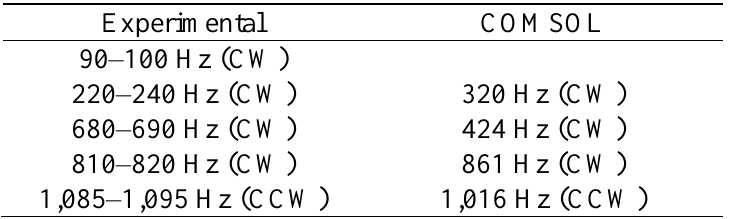
Table 1. Comparison between experiment and model mode frequencies.